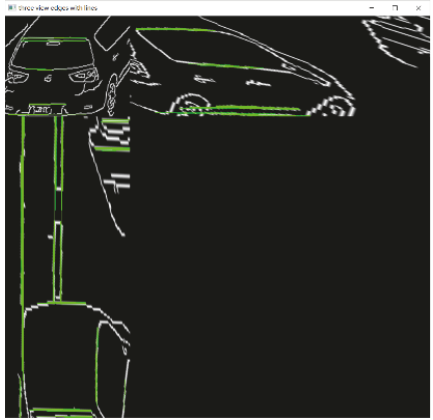
Figure 42: Extraction result of the line in the left view of truck.